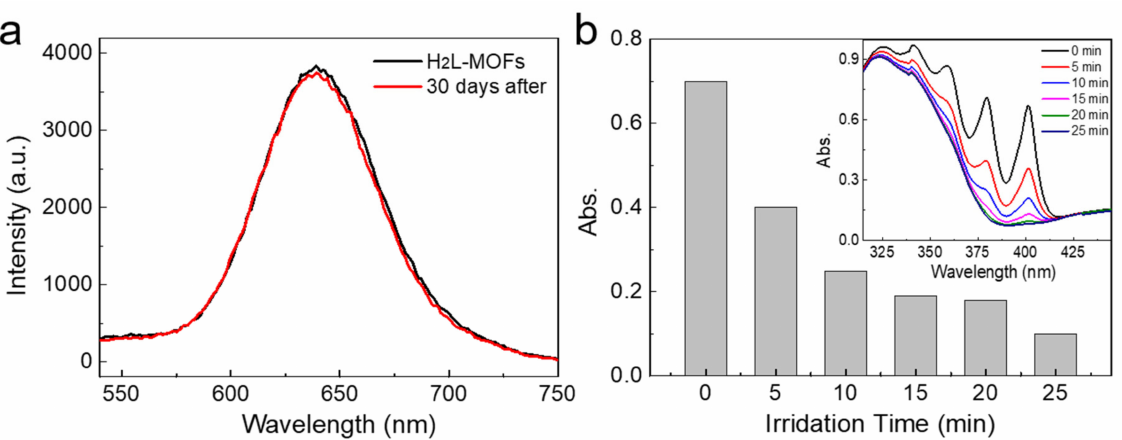
Figure 2. Optical properties of H 2 L-MOF nanoparticles. ( a ) The fluorescence spectrum of H 2 L-MOF nanoparticles right after the growth and 30 days after the growth. ( b ) The UV-vis absorbance intensity of ABDA at 380 nm after the addition of H 2 L-MOFs and under irradiation for different time periods. Inset: the corresponding UV-vis absorption spectra of the mixture of ABDA and H 2 L-MOFs under different irradiation time